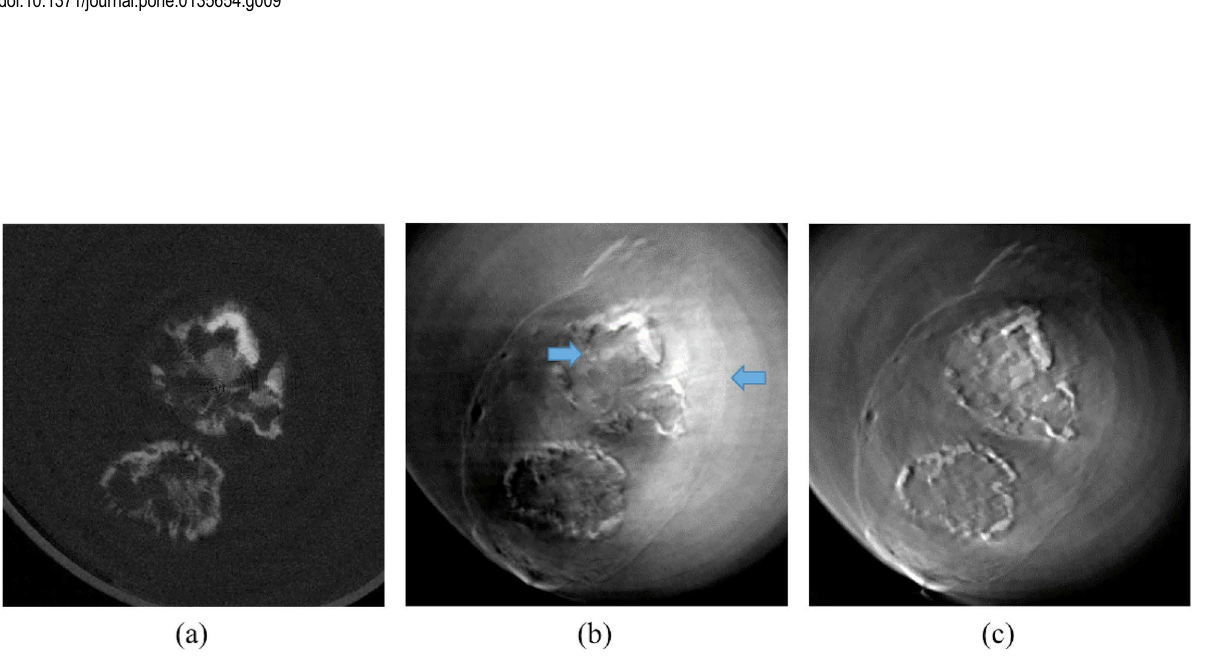
Fig 10. A cross-sectional slice at the level of the dashed line in Fig 8. Note the considerable reduction in beam deflection artefacts in (c) as compared to (b).